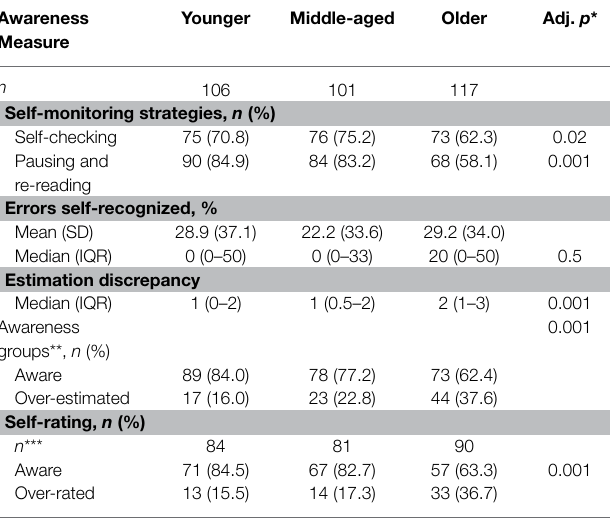
TABLE 3 | Awareness of performance on the WCPA-10 by age groups. Awareness Younger Middle-aged Older Adj. p * Measure